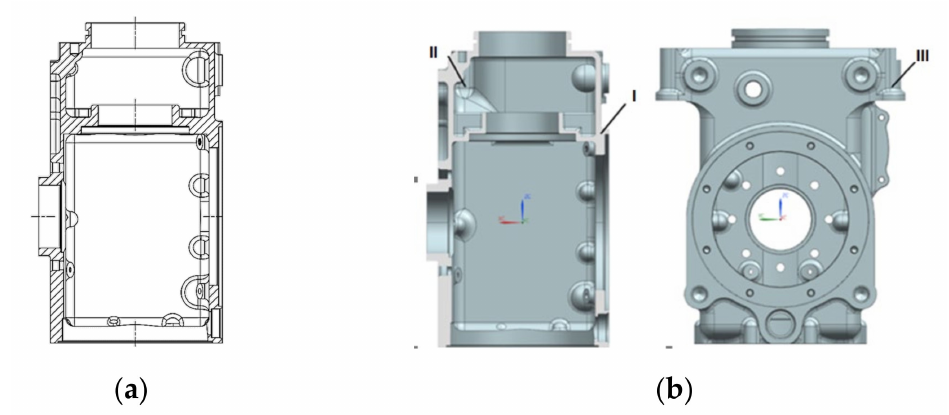
Figure 1. Lower angular gearbox housing: original design ( a ) and modification areas ( b ).